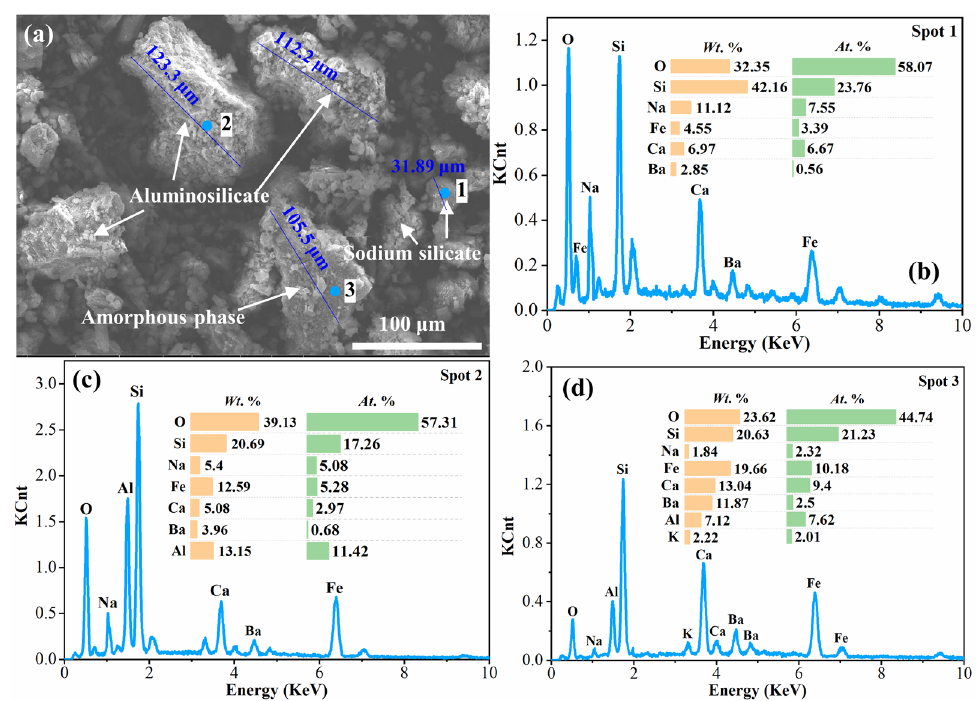
Figure 7. SEM image and EDS analysis of the water leaching residue at 5 min: ( a ) SEM image of the water leaching residue at 5 min; ( b ), ( c ) and ( d ) EDS analysis of Spot 1, Spot 2 and Spot 3, respectively, in Figure 7a.